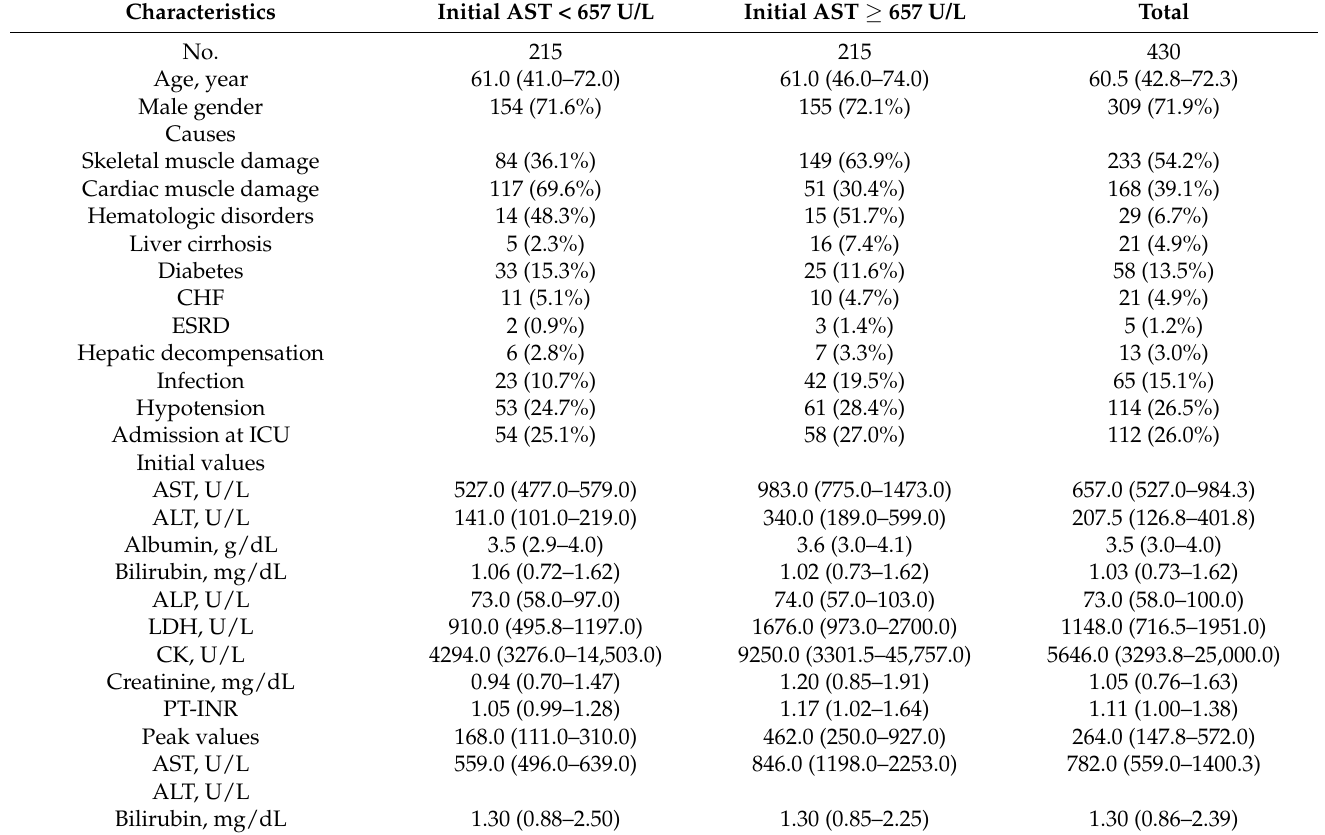
Table 1. Clinical and laboratory characteristics of patients ( n =